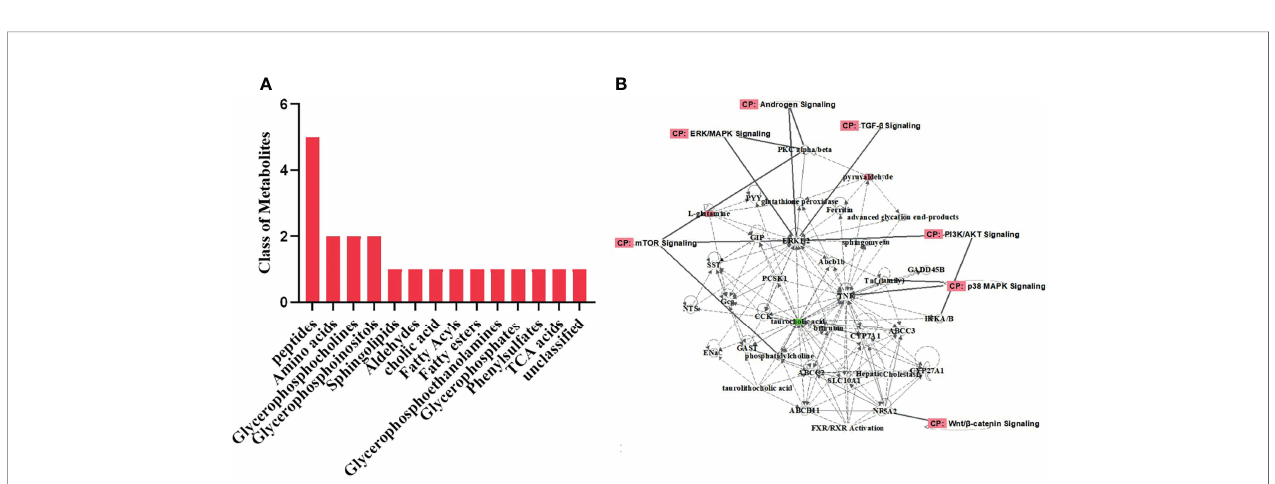
FIGURE 6 | Classi fi cation of the differential metabolites and IPA. (A) Classi fi cation of the differential metabolites was roughly categorized into 12 distinct classes. (B) IPA of the metabolites related to biological network, pathways, and functions. The differential metabolites were closely associated with the PI3K/AKT, MAPK, and Wnt signaling pathways. IPA , ingenuity pathway